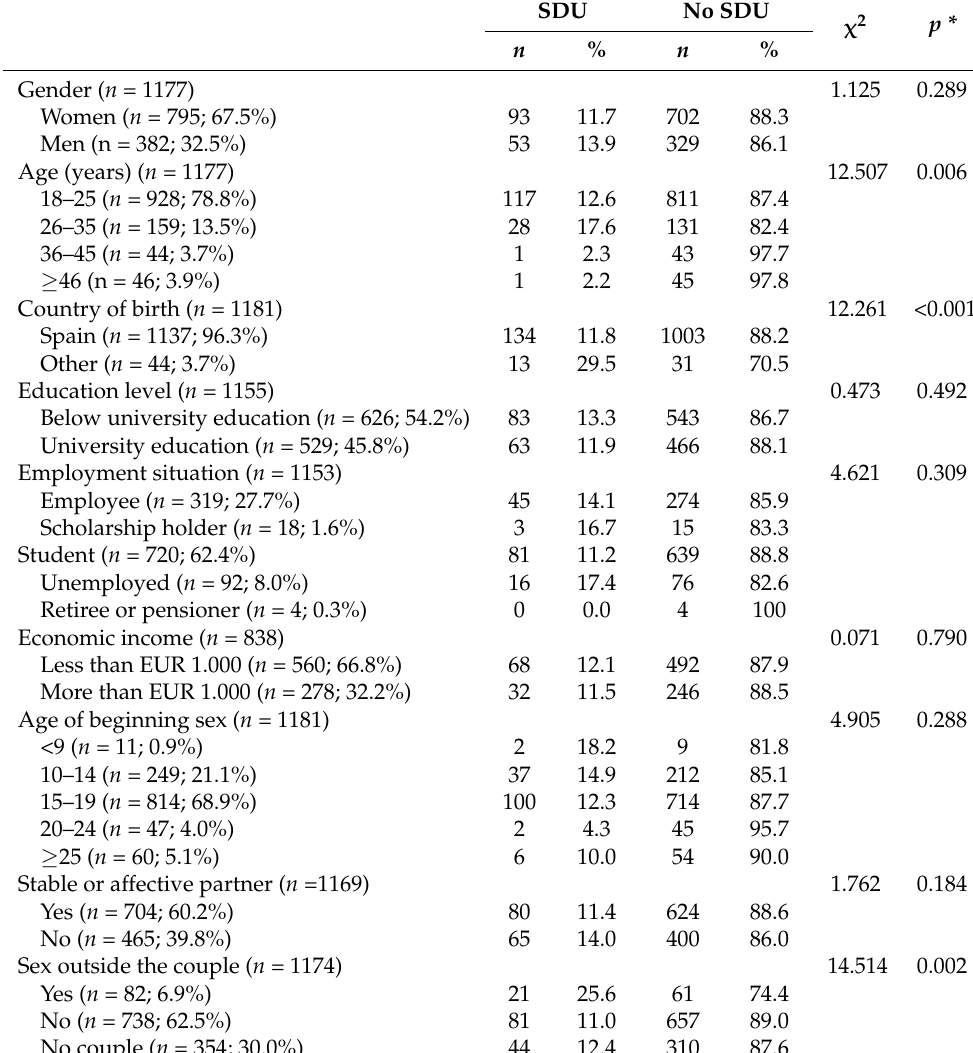
Table 1. Associations Between the SDU and the General Characteristics of the